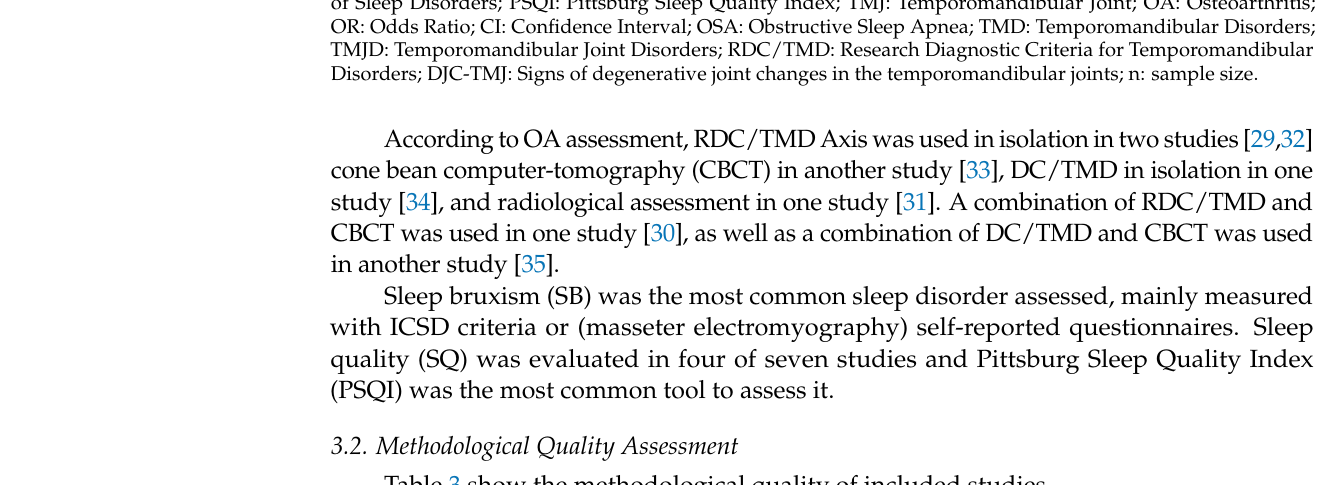
Table 3 show the methodological quality of included studies. Table 3. Newcastle-Ottawa Scale for assessing quality